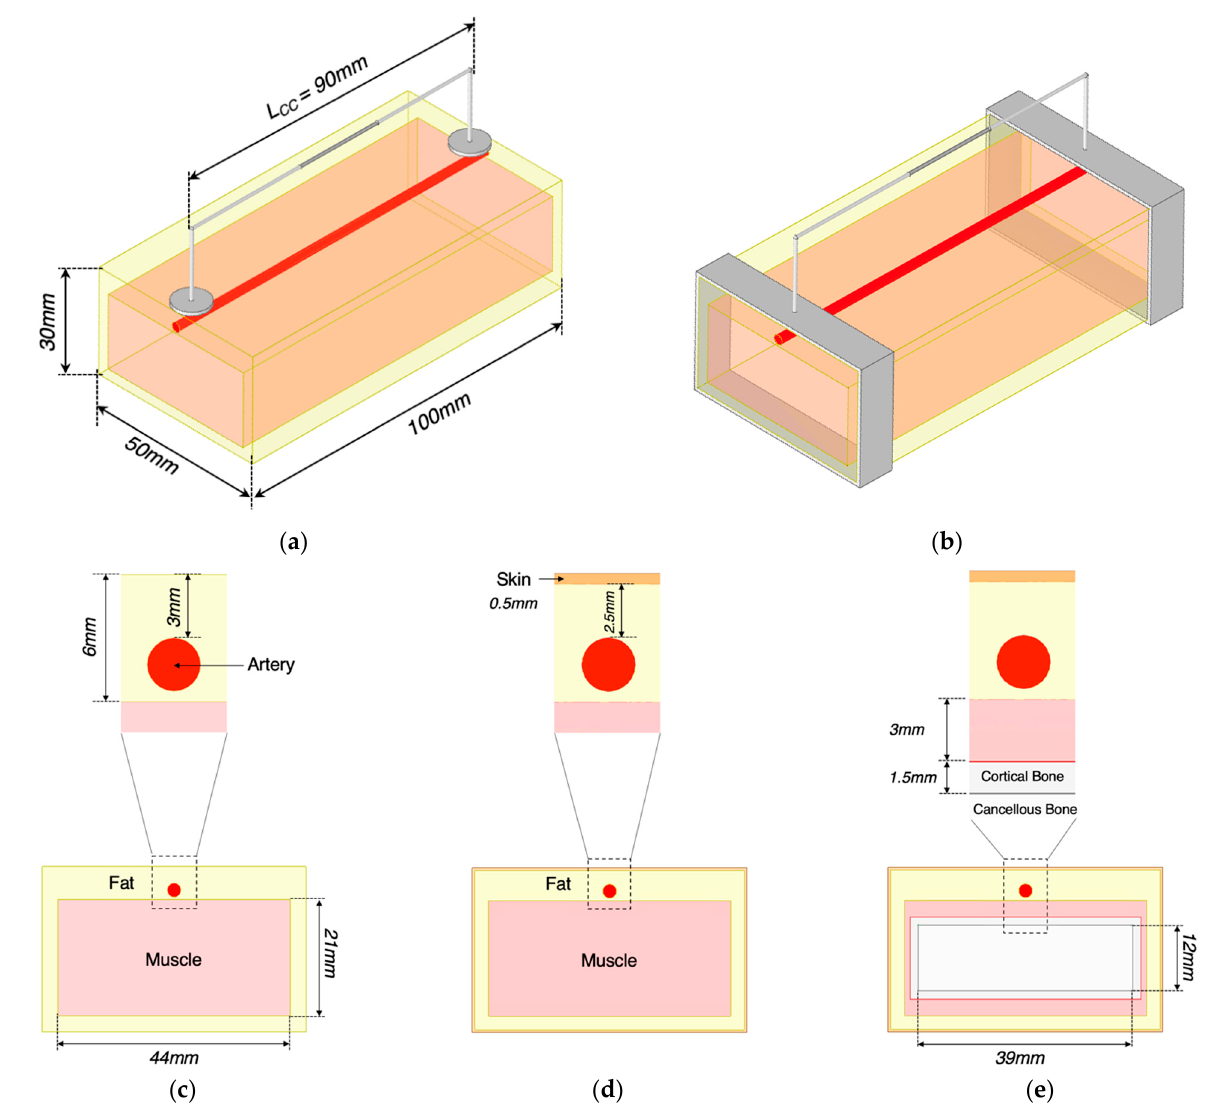
Figure 5. Description of 3D models in ANSYS HFSS: ( a ) conventional spot electrodes setup; ( b ) band electrodes setup; ( c ) a cross ‐ section of the wrist model 1; ( d ) a cross ‐ section of the wrist model 2; ( e ) a cross ‐ section of the wrist model 3. Table 1. Stages for computational simulation.